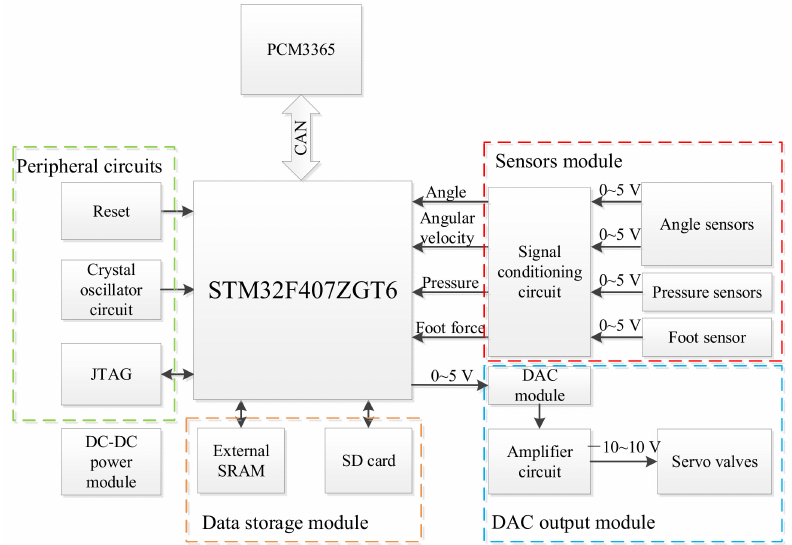
Figure 4. The hardware structure of the embedded controller.